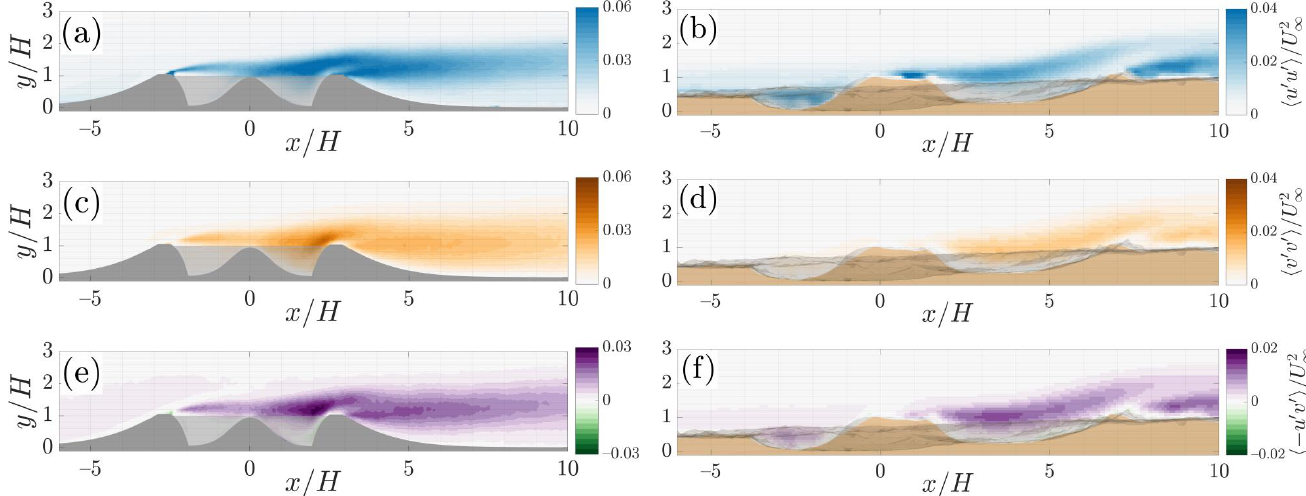
Figure 20. Contours of normalized Reynolds stress components in the idealized ( left ) and Gale Crater models ( right ). ( a , b ) (cid:104) u (cid:48) u (cid:48) (cid:105) , ( c , d ) (cid:104) v (cid:48) v (cid:48) (cid:105) , and ( e , f ) (cid:104)− u (cid:48) v (cid:48) (cid:105)